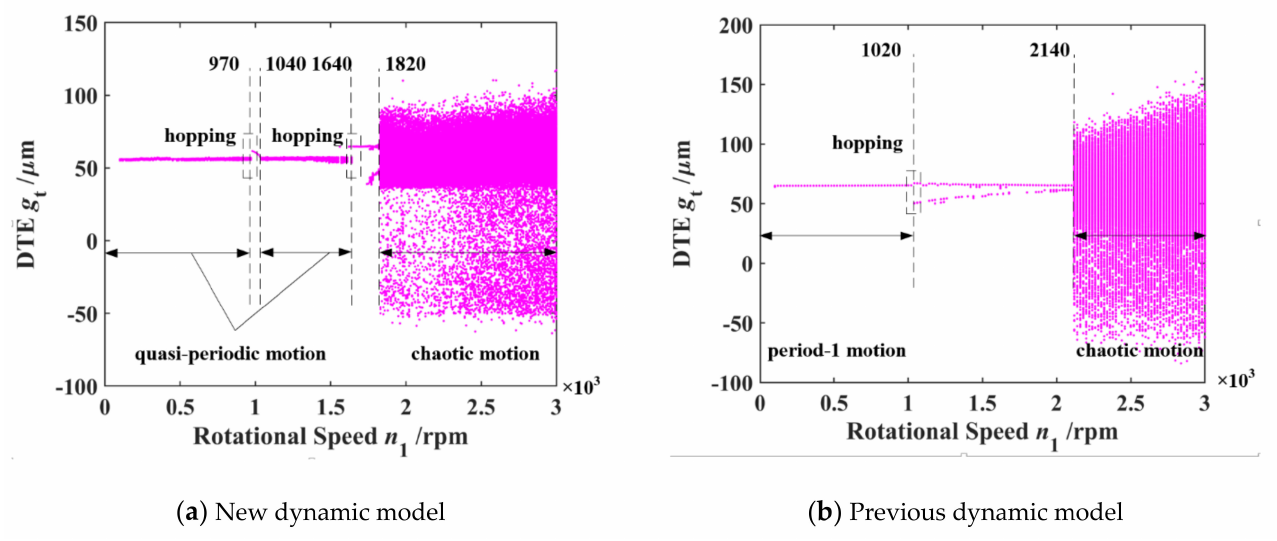
Figure 14. Bifurcation diagram of DTE with respect to rotational speed n 1